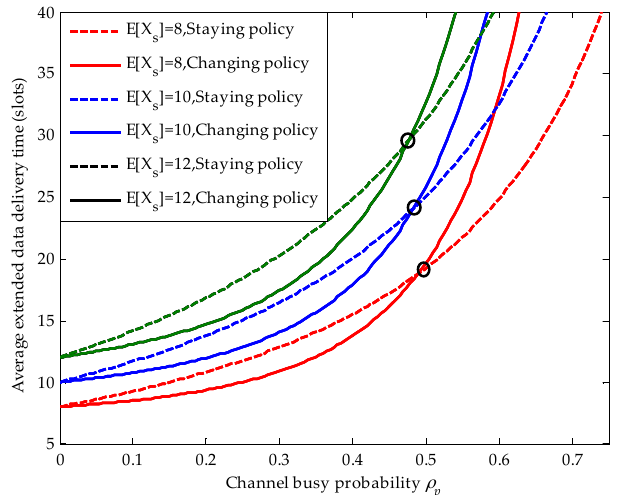
Figure 7. The effects of the secondary connection average service time on the average extended data delivery time in the preemptive repeat identical (PRI) M/G/1 queuing network, where the primary connection follows the exponential distribution, λ s “ 0.01 (arrivals/slot), λ p “ 0.02 (arrivals/slot),